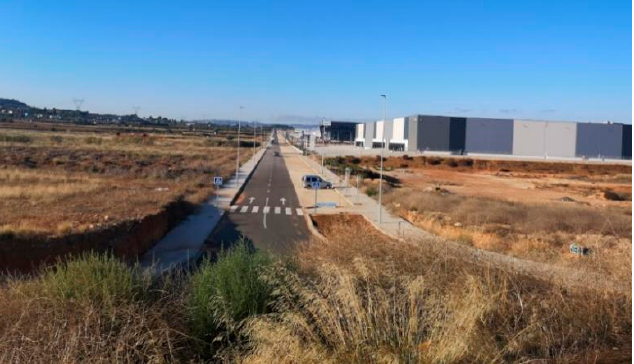
Figure 6. Scenario used for V2I experiments and the point of transmitter placement.